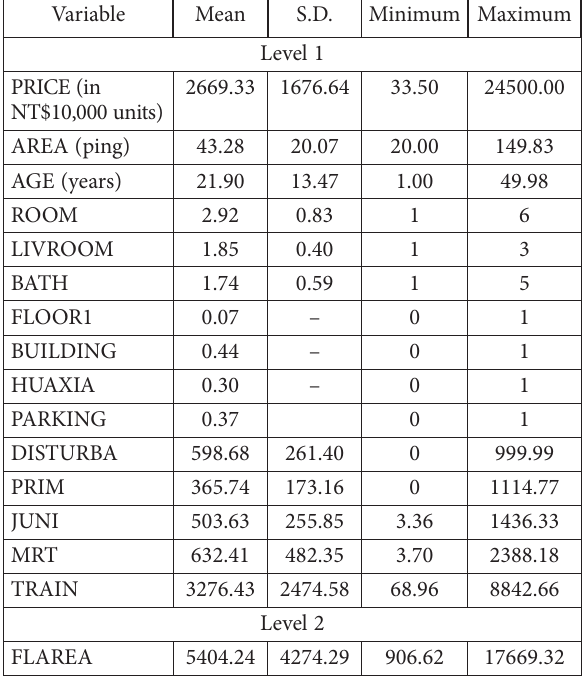
Table 2. Descriptive statistics of the sample